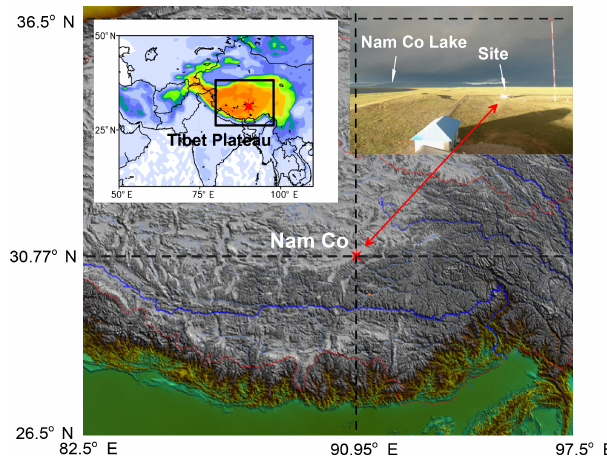
Figure 1. Map showing the location of the observation site and the local environment.